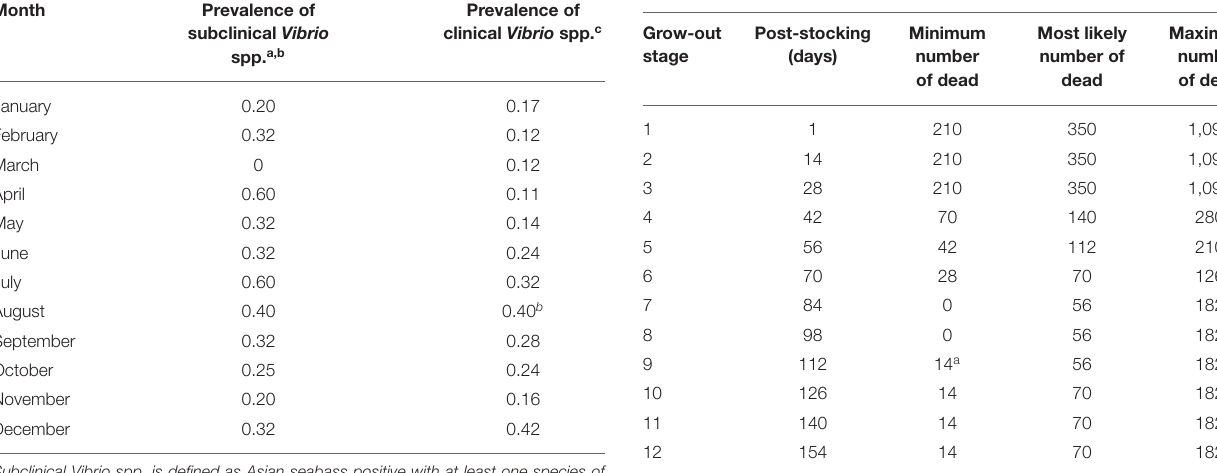
TABLE 1 | Data on the prevalence of subclinical and clinical Vibrio spp. TABLE 2 | The number of dead fish per stage is modeled using Riskpert (minimum, most likely, and the maximum number of dead).